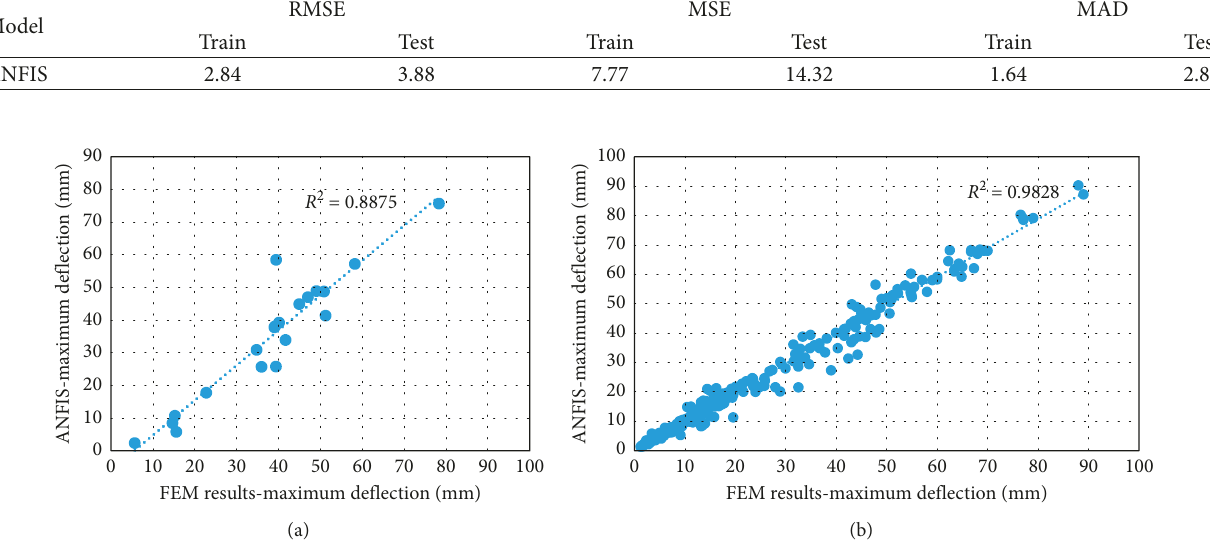
Figure 5: Relationship between the measurements (FEM results) and ANFIS predictions at (a) the test step of the ANFIS model and (b) the training step of the ANFIS model. Table 7: RMSE and MAPE errors in the strength limit state.